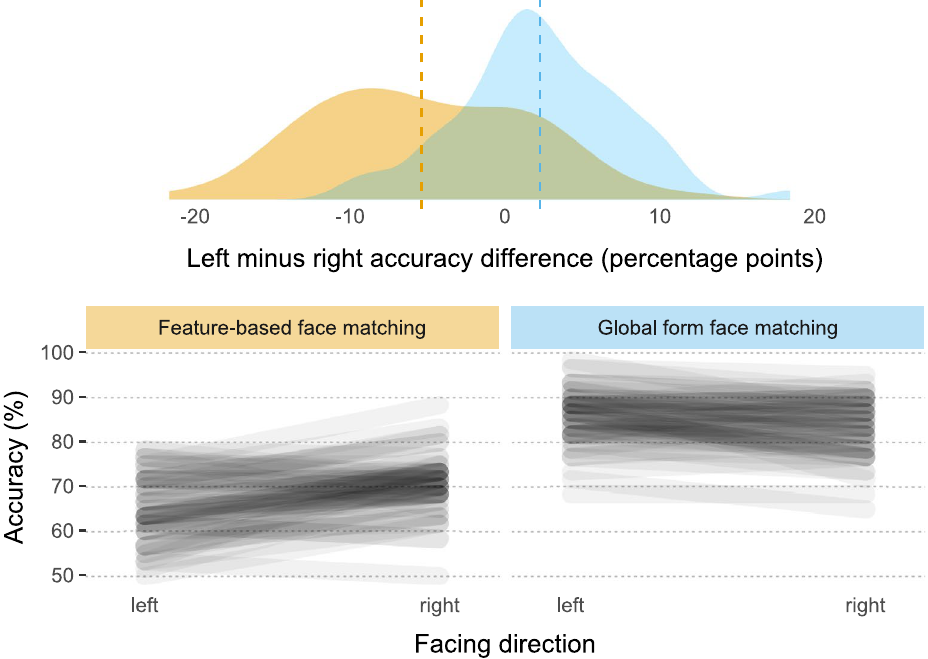
Figure 3. Performance by orientation of faces (facing direction). Accuracy for feature-based face matching was poorest for leftward-facing stimuli and greatest for rightward-facing stimuli. The opposite laterality pattern was seen for global form face matching. Upper panel: Density estimates for laterality effects (percent correct for left- facing stimuli minus percent correct for right-facing stimuli) in feature-based face matching (yellow) and global form face matching (blue). Mean laterality effects are shown as vertical dashed lines. Lower panels: Individual participants’ scores for left-facing and right-facing stimuli in feature-based face matching (left panel) and global form face matching (right panel) are shown as connected